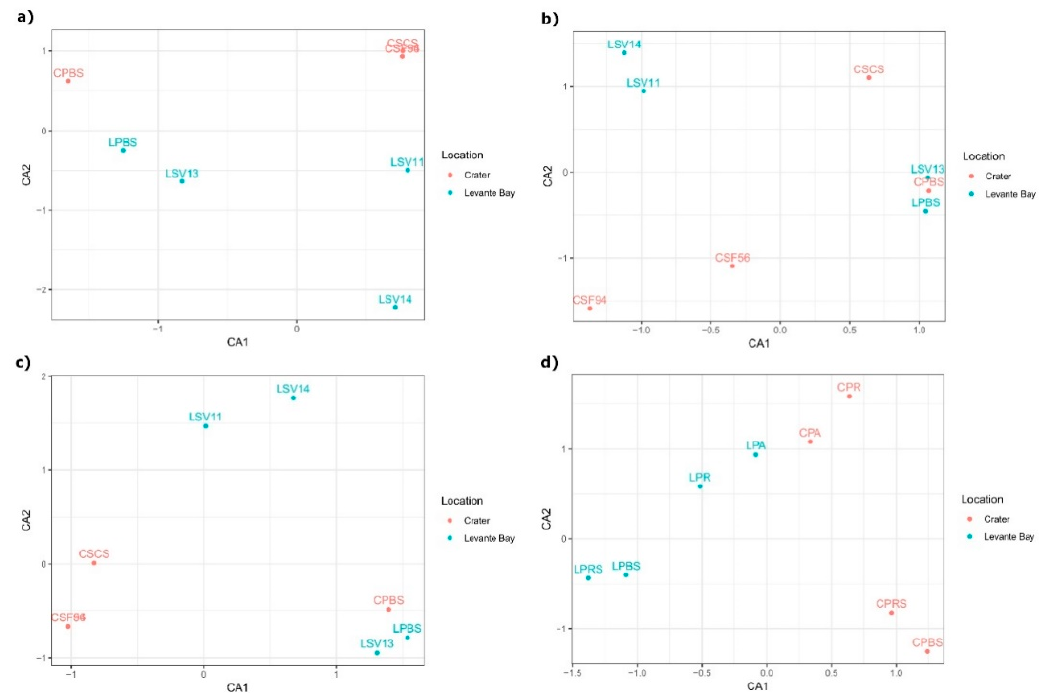
Figure 4. Correspondence analysis (CA) ordination analysis of samples based on ( a ) soil microbiome taxonomic composition; ( b ) soil gas emissions; ( c ) soil microbiome taxonomic composition collapsed at the genus level; ( d ) plant microbiome taxonomic composition.